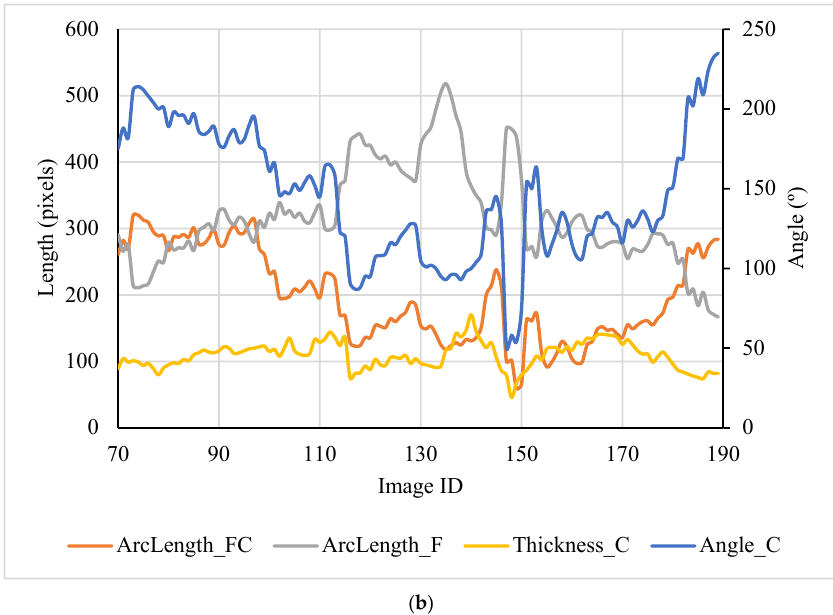
Figure 3. Eight features at 120 cross sections as well as the corresponding post-stenting lumen area: ( a ) area features, and ( b ) length features and calcification angle.